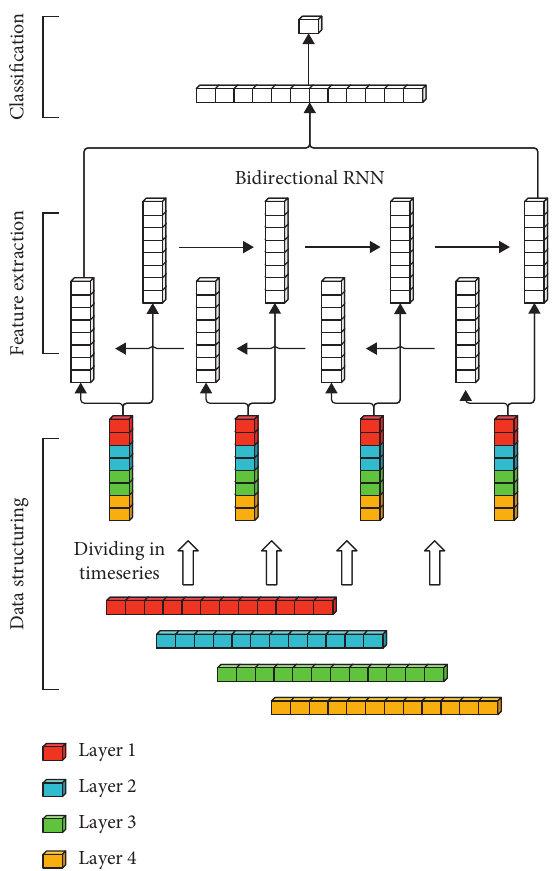
Figure 4: Framework of the temporal model based on